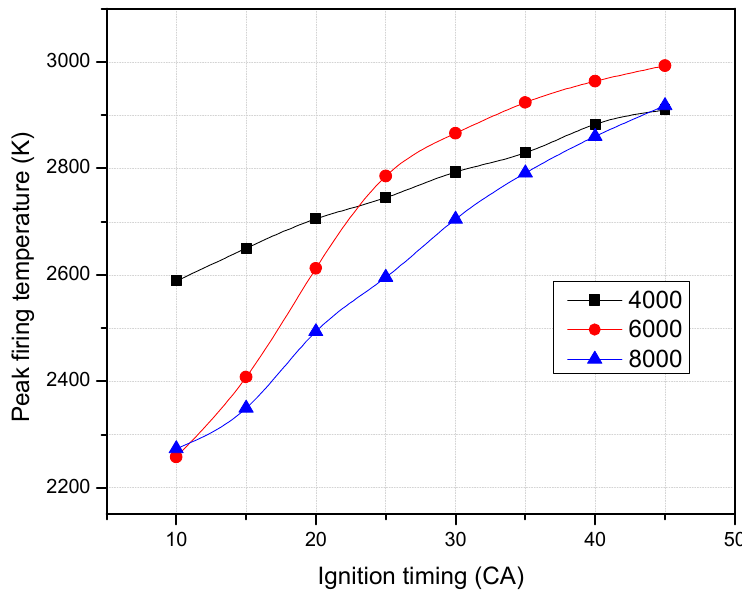
Figure 9. Peak firing temperature versus ignition timing.